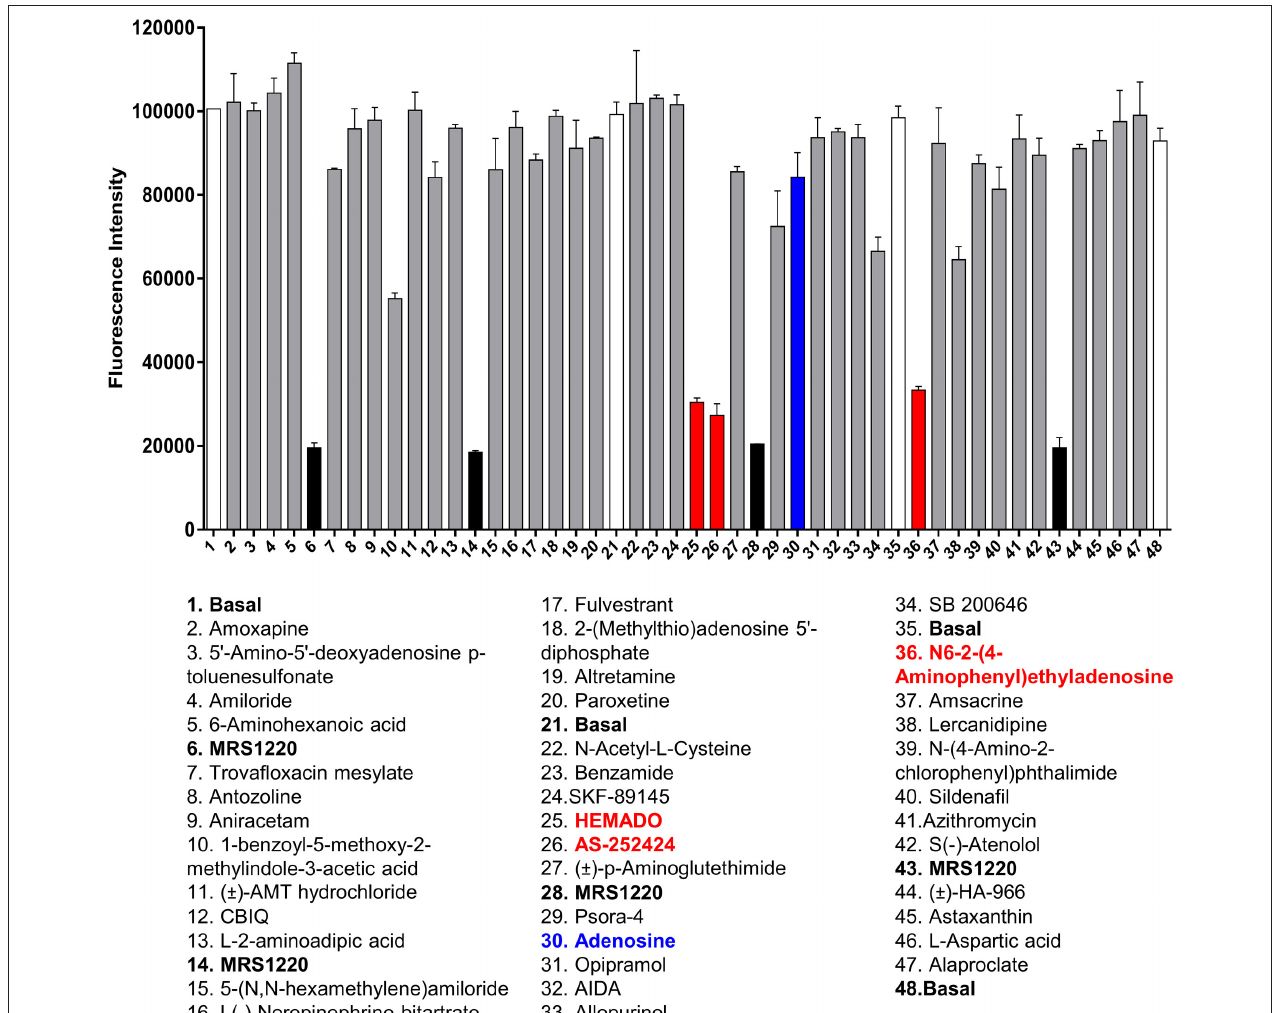
FIGURE 3 | Screening the LOPAC library against the A 3 AR. Example of the data generated from one plate of compounds from the LOPAC library. Each plate contained 40 compounds (each at 10 µ M final concentration) from the LOPAC library in duplicate along with four basal and four MRS1220 (10 µ M) controls, also in duplicate. The fluorescence intensities obtained on the PHERAstar FS from this plate are shown as mean and range of duplicates with the hits highlighted in red and adenosine indicated in blue. The plate shown is a representative plate of one of the three experiments performed using these compounds and the inhibition data for all compounds screened can be found in Supporting Information Table